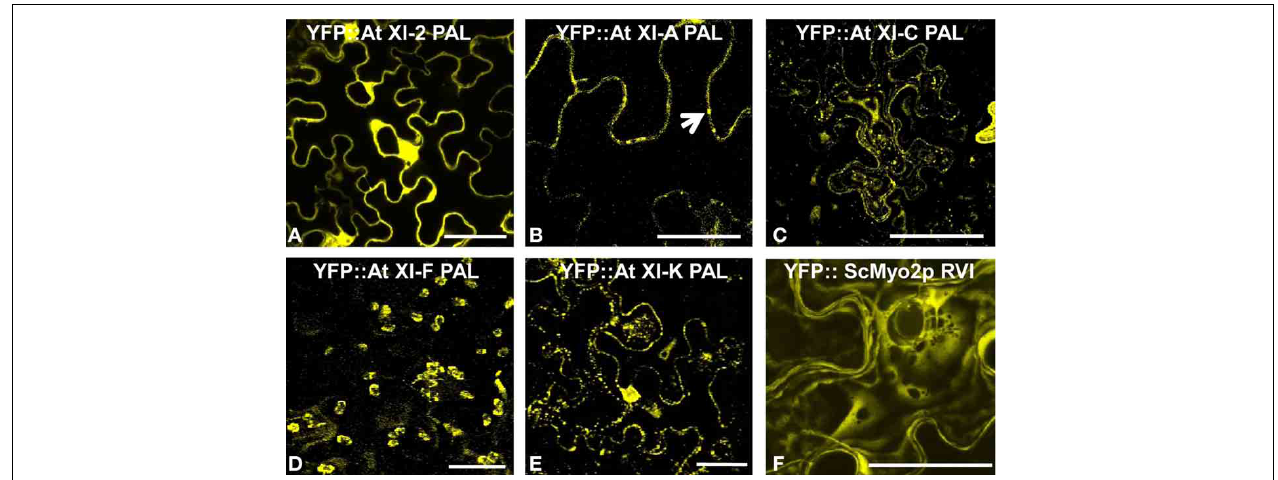
FIGURE 2 | Transient expression of YFP:: Myosin PAL sub-domains. Agrobacterium-mediated transient expression of YFP fusions of PAL sub-domains in epidermal cells of N. benthamiana (A) At XI-2. (B) At XI-A. (C)